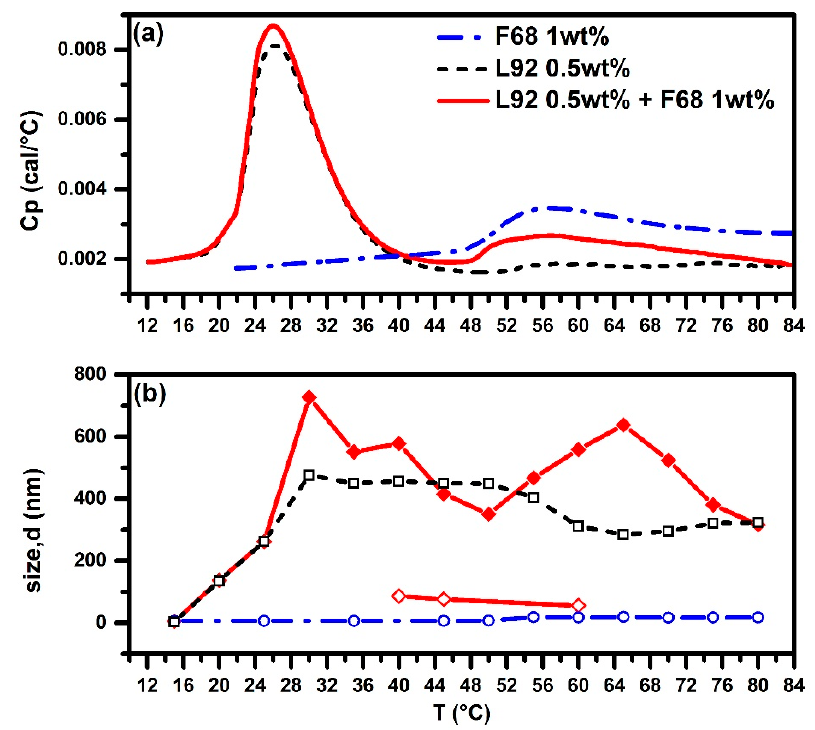
Figure 3. HSDSC thermograms ( a , b ) and evolution of size of aggregates ( c , d ) as a function of temperature from DLS; ( a , c ) Mixed Pluronic 0.5 wt % L92 + 1 wt % F108 system; ( b , d ) Mixed Pluronic 0.5 wt % L92 + 1 wt % F98 system. Red solid line and diamond ( ◆ ) for mixed Pluronic system. Black dashed line and open square ( □ ) for L92. Blue dashed-dotted line and open circle ( ○ ) for F108/F98.